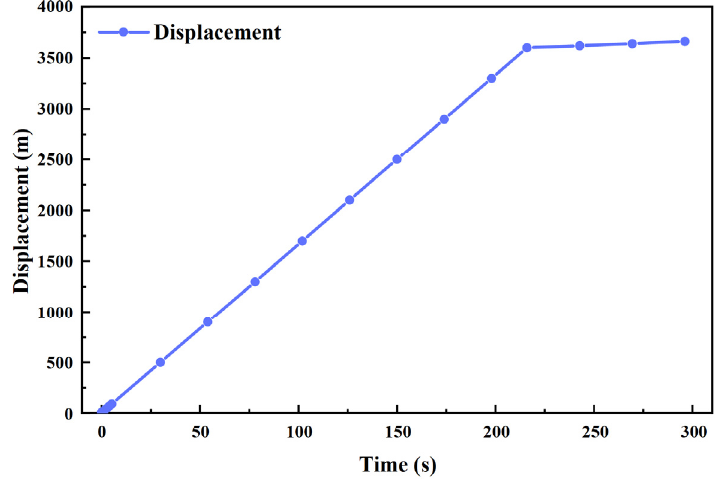
Figure 10. Downward displacement of the plunger.